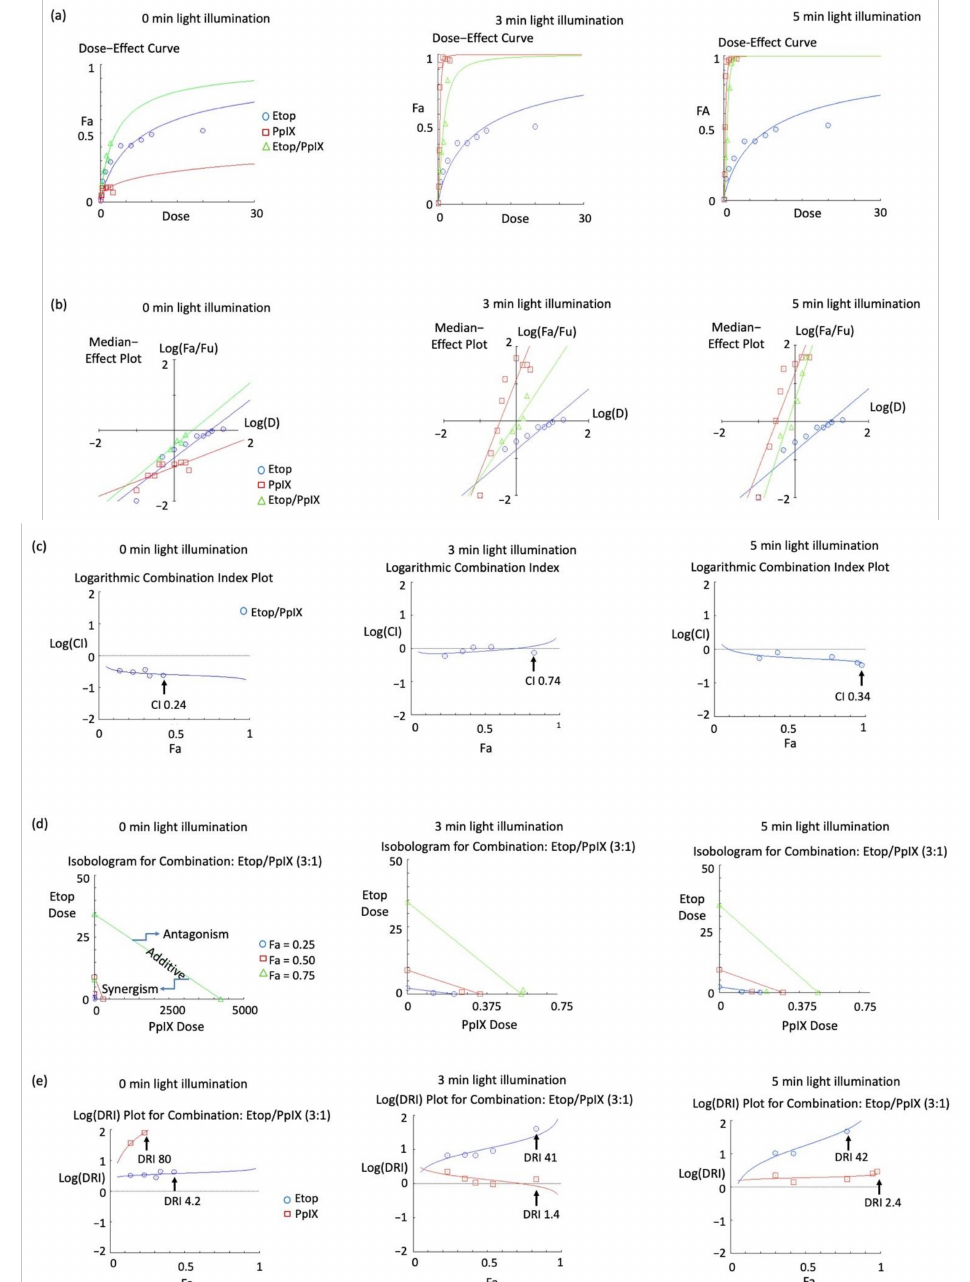
Figure 5. The graphical outputs from the CompuSyn software using cytotoxicity data for Etop, PpIX PDT, and phototherapy with Etop plus PpIX. ( a ) The dose-effect curve showed superior response for Etop plus PpIX even in the absence of light illumination; the response profile was below that of PpIX PDT for 3 min light illumination and became almost identical to that of PpIX PDT at 5 min light illumination. ( b ) The light-dependent effect of PpIX PDT and phototherapy with Etop plus PpIX was manifested by a shift in the x-intercept on the median-effect plot. ( c ) The CI at the highest tested dose revealed strong synergism for Etop plus PpIX without light illumination, synergism for 5 min light illumination, and moderate synergism for 3 min light illumination. ( d ) The isobologram showed regions of synergism and antagonism for specific Fa; an illumination time-dependent dose reduction possible for both Etop and PpIX in the combined treatment was evident. ( e ) Phototherapy with Etop plus PpIX was associated with a favorable dose reduction for Etop and less so for PpIX at the high Fa range. Dose reduction was also possible in the absence of light illumination, but this was less relevant due to the low attainable Fa value in the tested dose range. (CI—combination index, DRI—dose-reduction index, Etop—etoposide, PDT—photodynamic therapy, PpIX—protoporphyrin